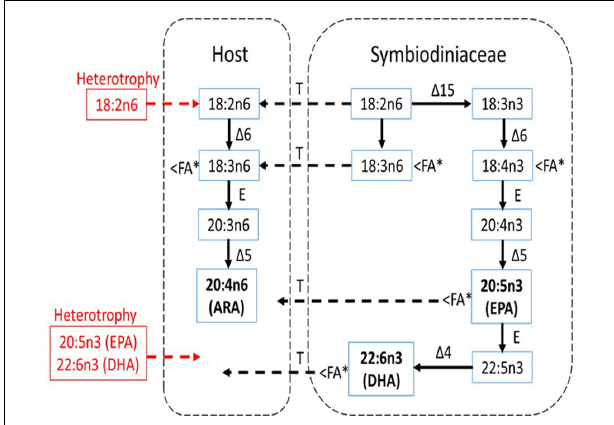
FIGURE 9 | The pathway of biosynthesis of n-3 and n-6 PUFA in shallow-water coral ( A. digitifera ) and a scheme for the possible transport of these FA between the host and symbiotic algae (Symbiodiniaceae) under experimental condition (modified from Imbs et al., 2010b). Essential FA components (ARA, EPA, and DHA) are bold while the red color shows the essential FAs that are not translocated from heterotrophy feeding. (cid:49) 4, (cid:49) 5, (cid:49) 6, and (cid:49) 15 are corresponding desaturase; E, elongase; T, transport. The < FA ∗ indicates FA component that was significantly reduced during the thermally induced